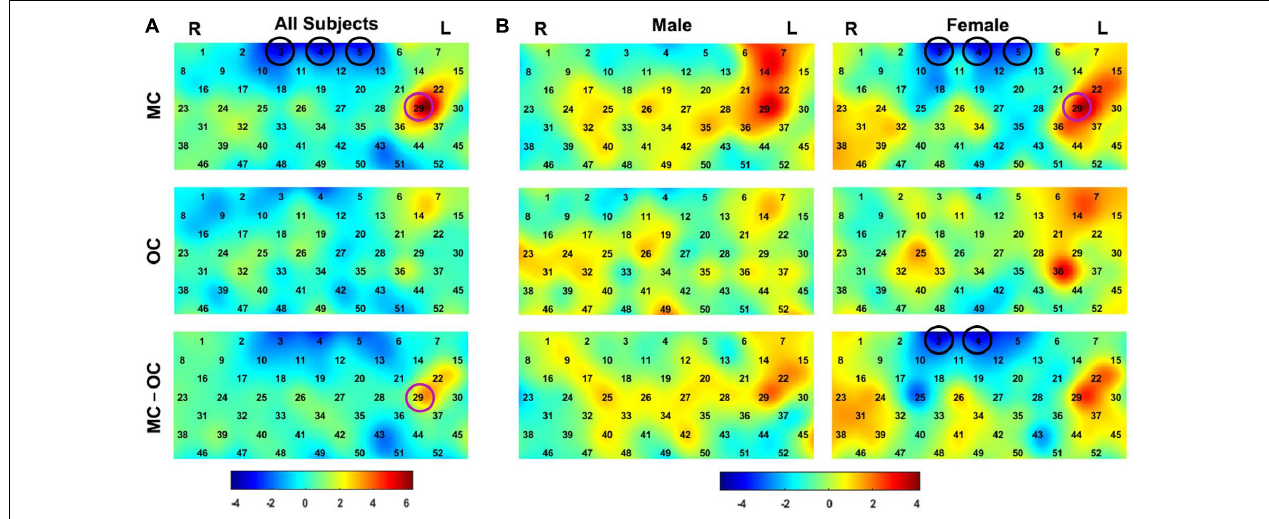
FIGURE 3 | The group-level activation t -maps for all the participants (A) and for different gender (B) . The black circles marked the significantly negatively activated channels in mPFC, and the purple circles marked the significantly positively activated channels in dlPFC. MC: the mixed culture condition. OC: the original culture